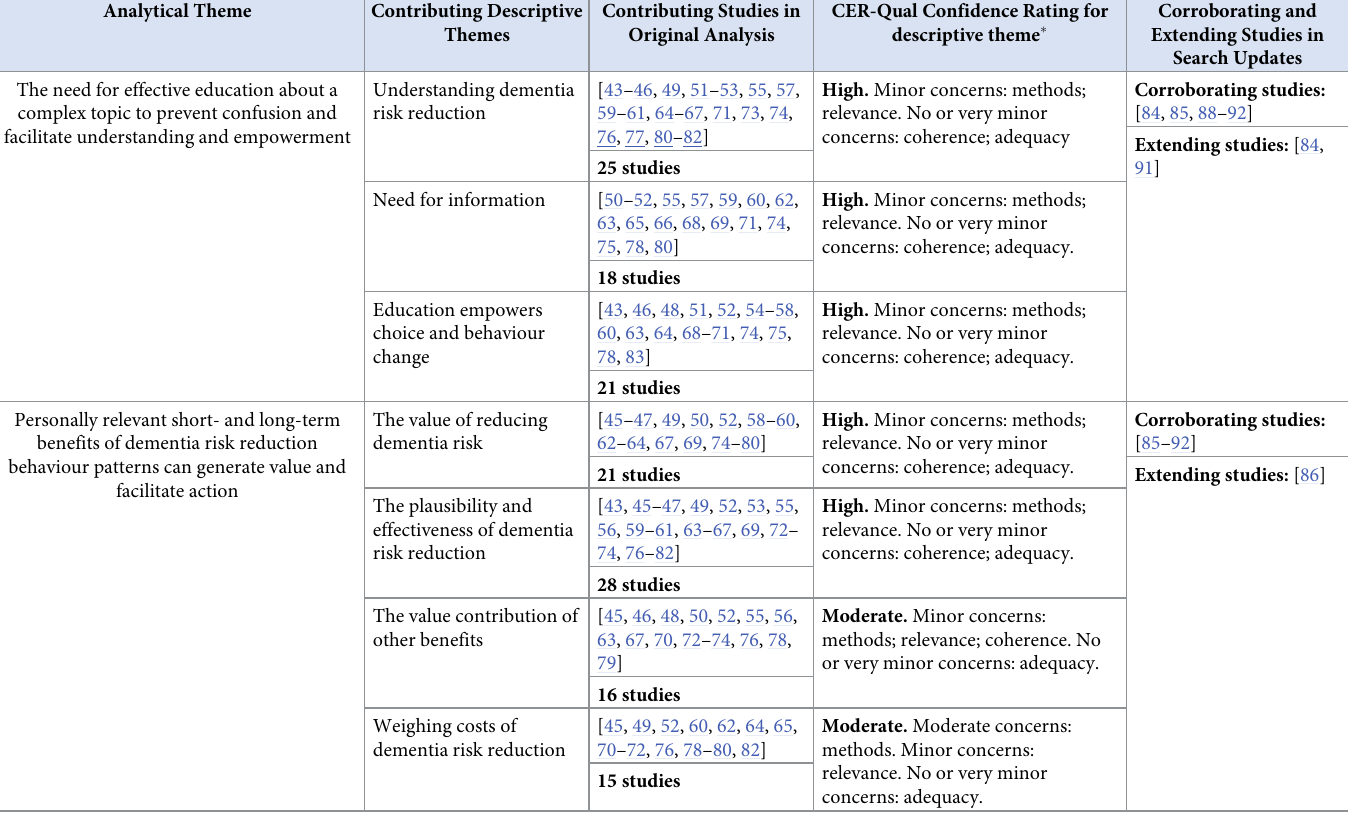
Table 3. Overview of thematic framework; contributing studies; confidence